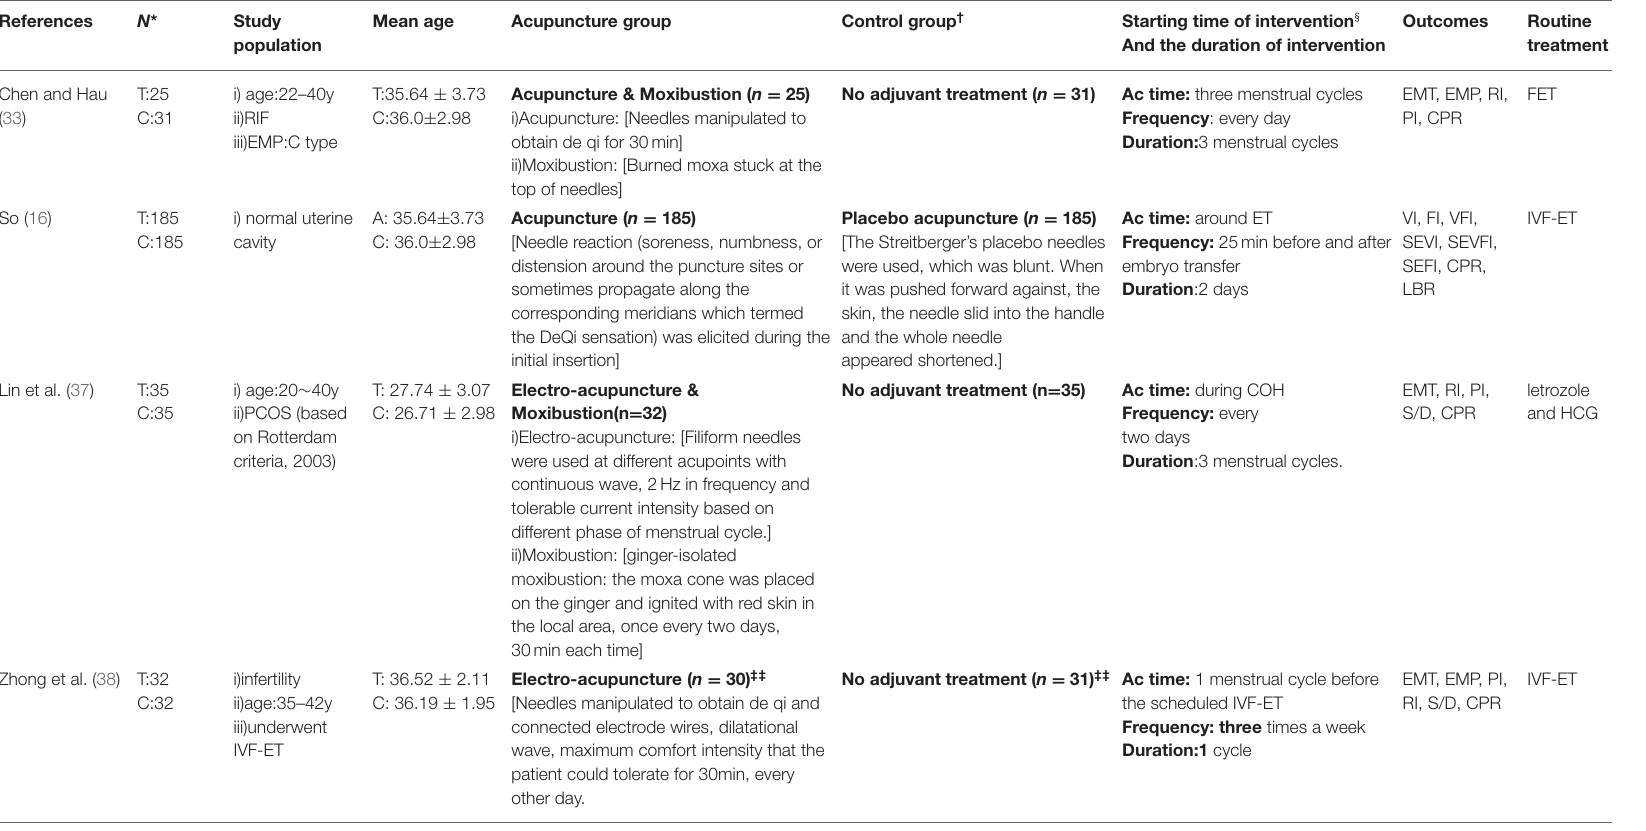
* Number randomized; † For the control group trials, the procedure was given the same as the acupuncture group; § Based on the start time of the first acupuncture session: in menstruation or after menstruation; ¶ Navel is an acupoint of Ren meridian based on Traditional Chinese Medicine (TCM); ‡12 patients in the control group were excluded from the study: four of them failed ovarian stimulation and the other eight participants were declined to participate further after randomization; ** Three groups were set in the trial, TESA vs. Mock TESA vs. no adjuvant control group, we collected the first group and the second group in our study; †† One patient in acupuncture group quitted and two patients in control group fell out due to incomplete data; k Two patients in the acupuncture group interrupted treatment because of out of work and one patient in the control group embryo transferred advanced; ‡‡ In acupuncture group, one patient dropped out and one was excluded due to insufficient data. In the control group, one patient dopped out. T, the treatment group; C, the control group; COH, control ovarian hyperstimulation; Ac, acupuncture; EMT, endometrial thickness; EMP, endometrial pattern; S/D, peak systolic velocity/ end-diastolic blood velocity; EMB, endometrial blood; RI, resistive index; PI, pulse index; IVF-ET, in vitro fertilization and embryo transfer; ET, embryo transfer; CPR, clinical pregnancy rate; TEAS, transcutaneous electrical acupoint stimulation; RIF, repeated implantation failures; HCG, human chorionic gonadotropin; PCOS, polycystic ovarian syndrome, ‡ §, ¶, k , ** , †† , ‡‡